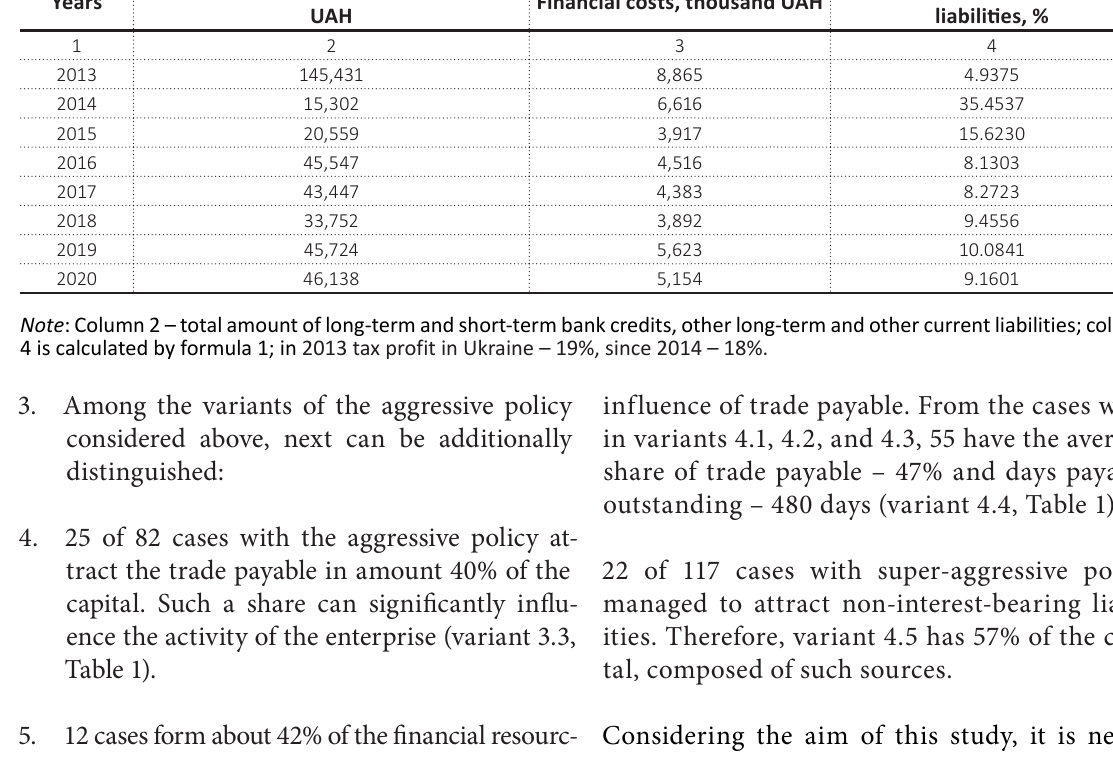
Table 2. The cost of the interest-bearing liabilities of Lagoda